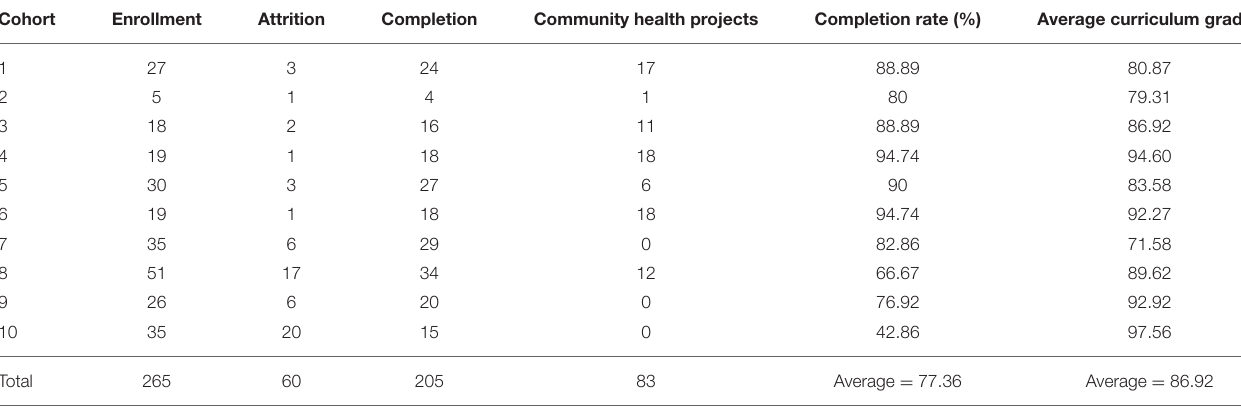
TABLE 2 | Online HSCHW curriculum completion rates and students grades.